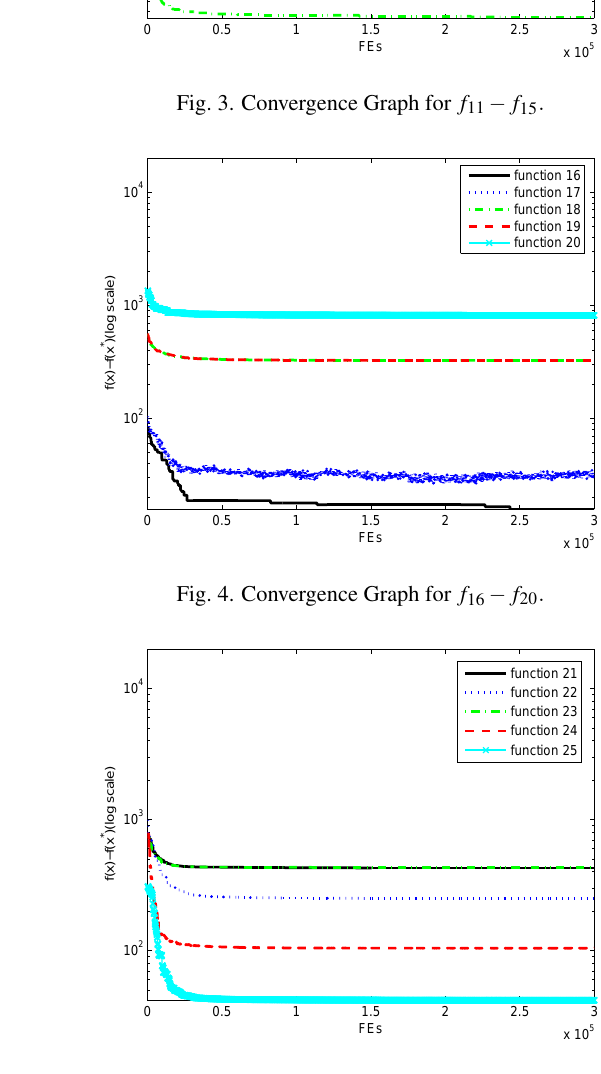
Fig. 5. Convergence Graph for f 21 − f 25